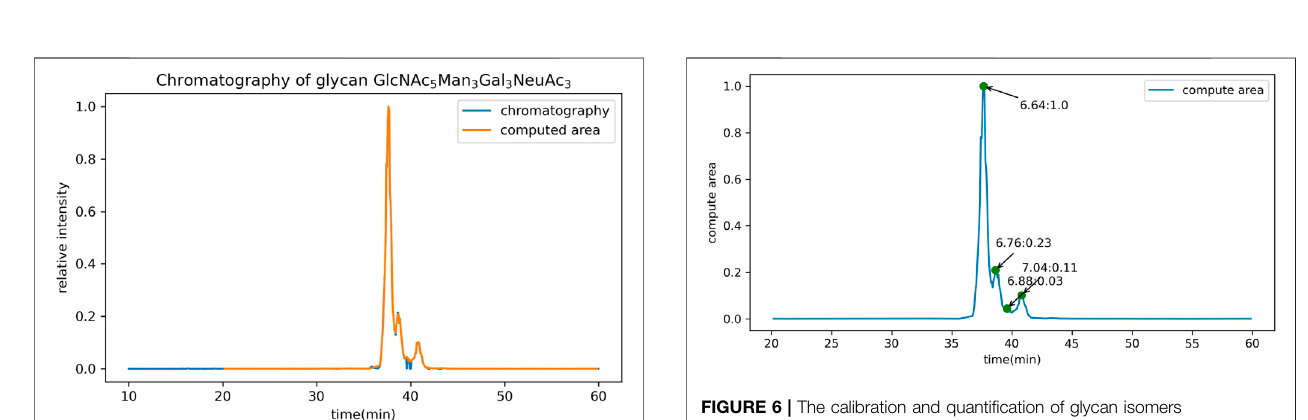
FIGURE 4 | The comparison of GUI values calibrated by using GlycanGUI and by manual calibration for the N-glycans in human serum glycomic data.